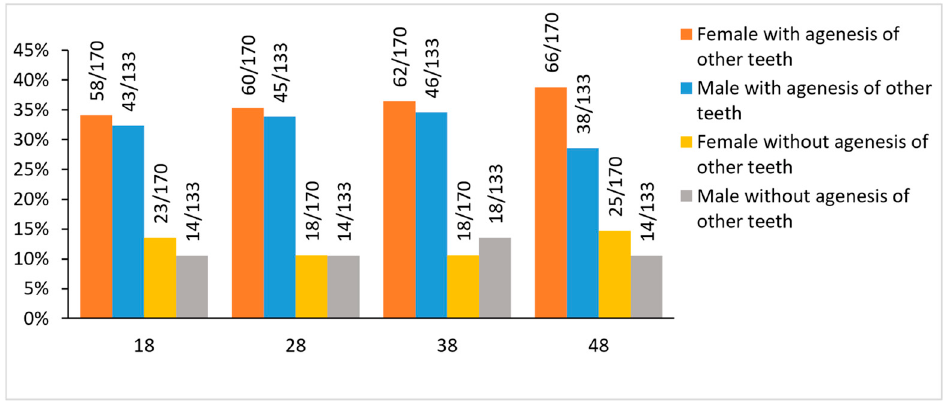
Figure 1. Third molar agenesis with and without agenesis of other